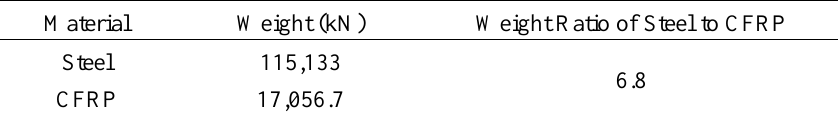
Table 4. Weight of steel and CFRP cables on a whole